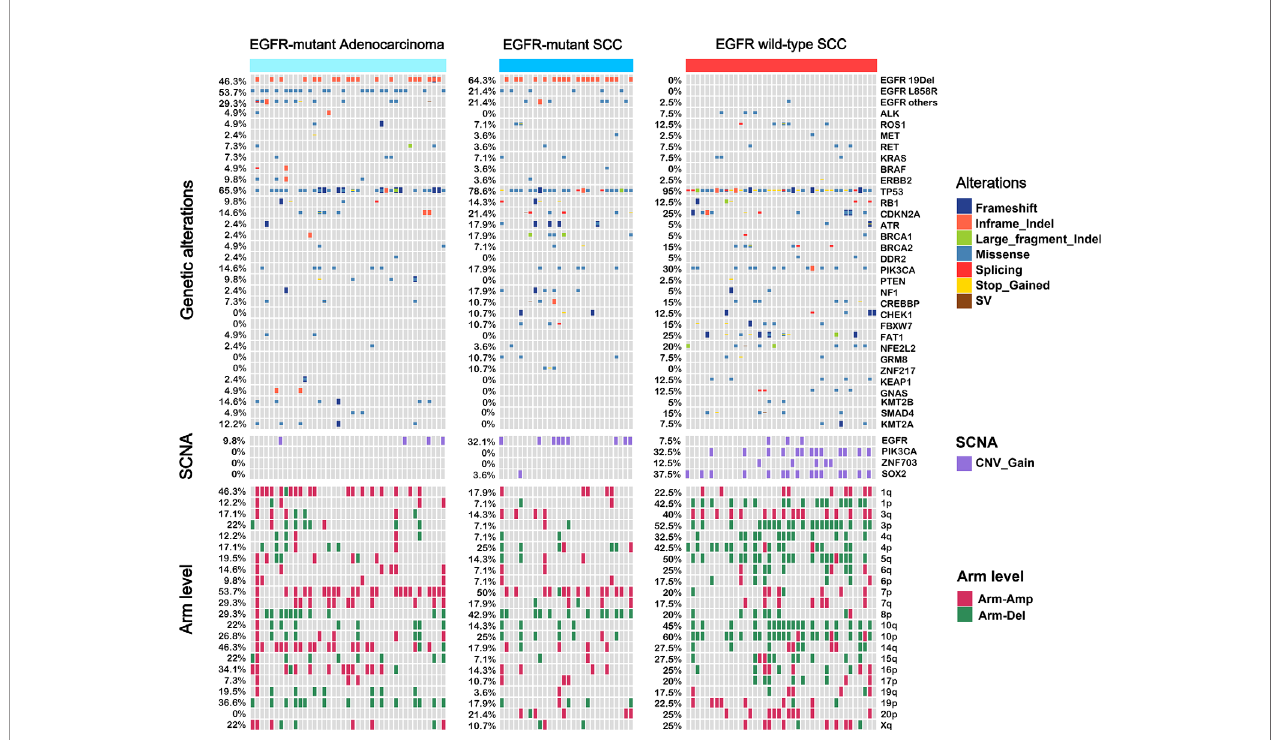
FIGURE 2 | The landscape of genomic pro fi les in EGFR -mutant adenocarcinoma, EGFR -mutant SCC, and EGFR wild-type SCC. 32 top-ranking genetic alterations (top panel), 4 somatic copy number alterations (SCNAs, middle panel), and 22 arm level alteration (bottom panel) in three subgroups ( EGFR -mutant adenocarcinoma, n = 28; EGFR -mutant SCC, n = 41; EGFR wild-type SCC, n = 40) were represented. Each column represented a sample.